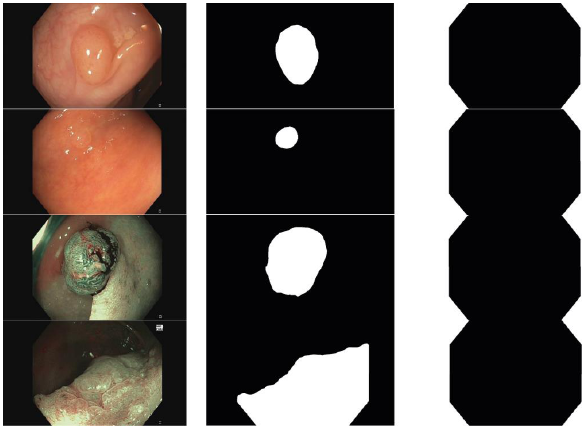
Figure 2. Examples of images and masks from the PICCOLO dataset. First two rows correspond to white light images, while last two rows are NBI images. First column corresponds to the polyp frame,